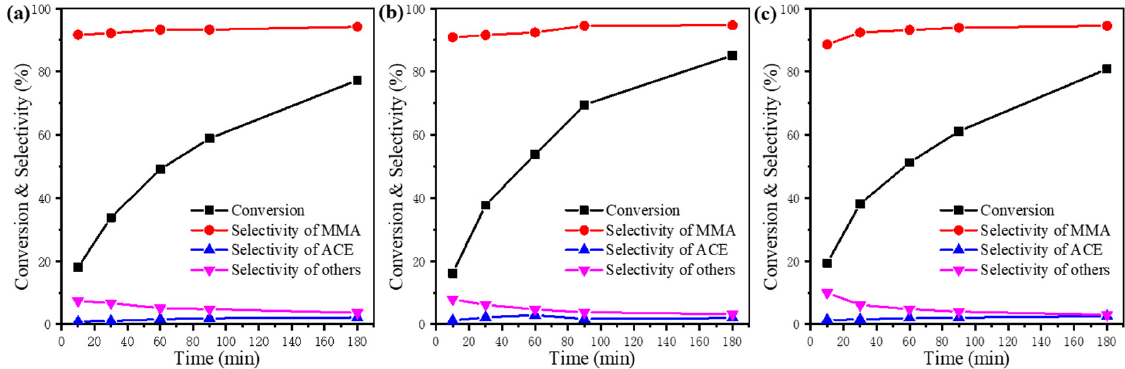
Figure 1. The products distributions of reaction with time courses over the ( a ) Au 25 /Zn 3 Al-400; ( b ) Au 25 /Zn 2 Al-400 and ( c ) Au 25 /Zn 1 Al-400 catalysts. Reaction conditions: MAL/MeOH = 1/23 (molar ratio), catalyst: 0.05 g, temperature: 353 K, O 2 pressure: 3 atm.